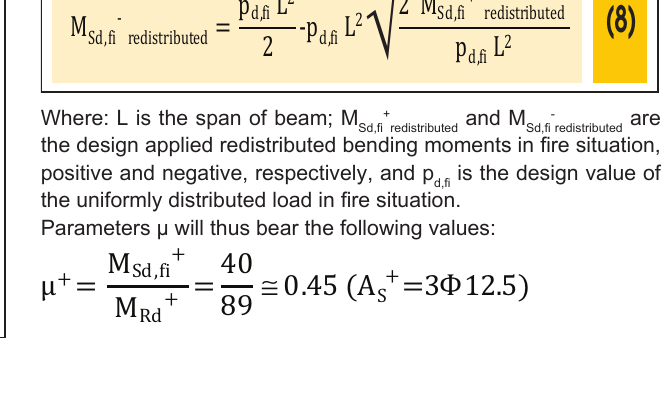
Figure 13 – Uniformly distributed load in